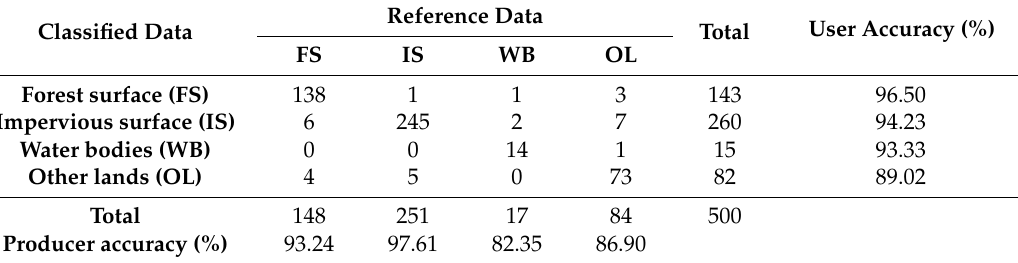
Table A2. Error matrix for the 2007 LULC